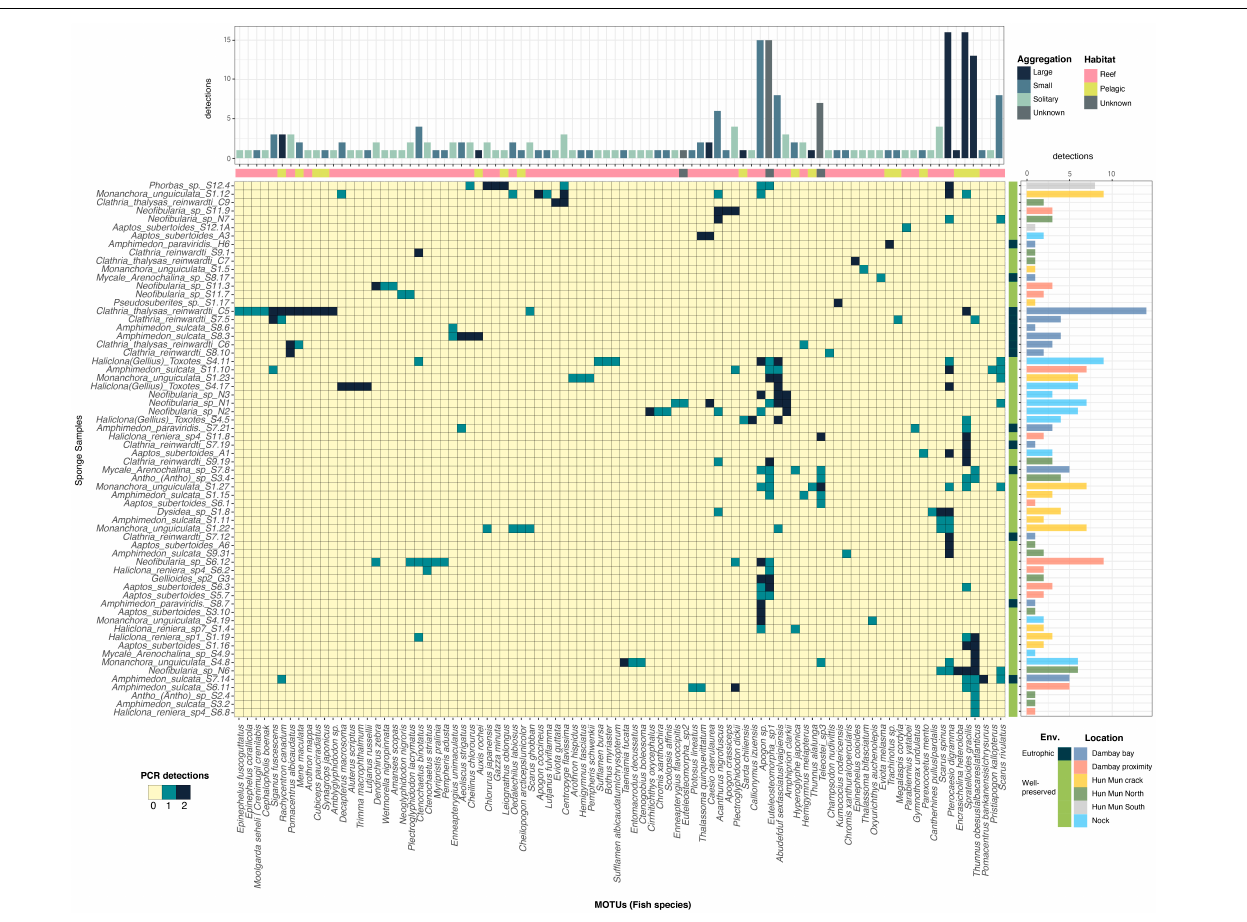
FIGURE 4 | Heatmap based on presence/absence data. The heatmap scale color indicates whether a MOTU is detected in 0, 1, or 2 PCR replicates of a sample. Sponges samples ( y -axis) and fish species ( x -axis) are ordered according to cluster dendrogram based on Jaccard distances (shown in Supplementary Figure S6 ). Bars indicate total detections (considering one detection independently of the number of replicates) of ( Upper panel ) Fish species (MOTUs) in all samples and ( Right panel ) Fish species in each sample. Bar color for y -axis indicates the sampling location and environment. Bar color for x -axis indicates the aggregation behavior and the habitat of fish